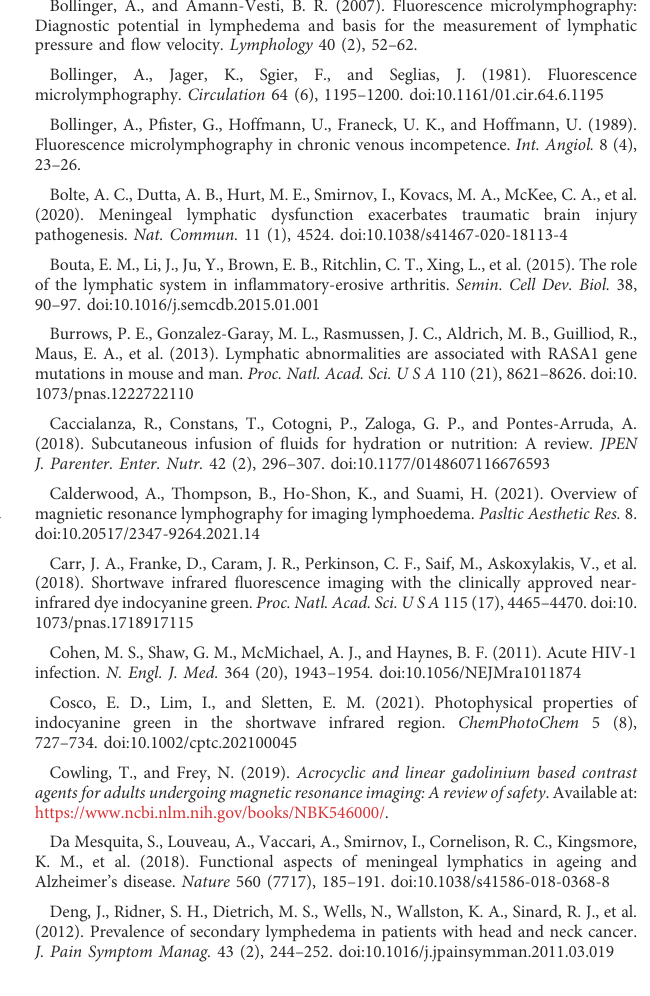
SUPPLEMENTARY VIDEO S1 Normal lymphatic drainage in the lower extremities of a healthy subject. SUPPLEMENTARY VIDEO S2 Lymphatic re fl ux in a patient with active ulceration. Reproduced with permission from (Rasmussen et al.,